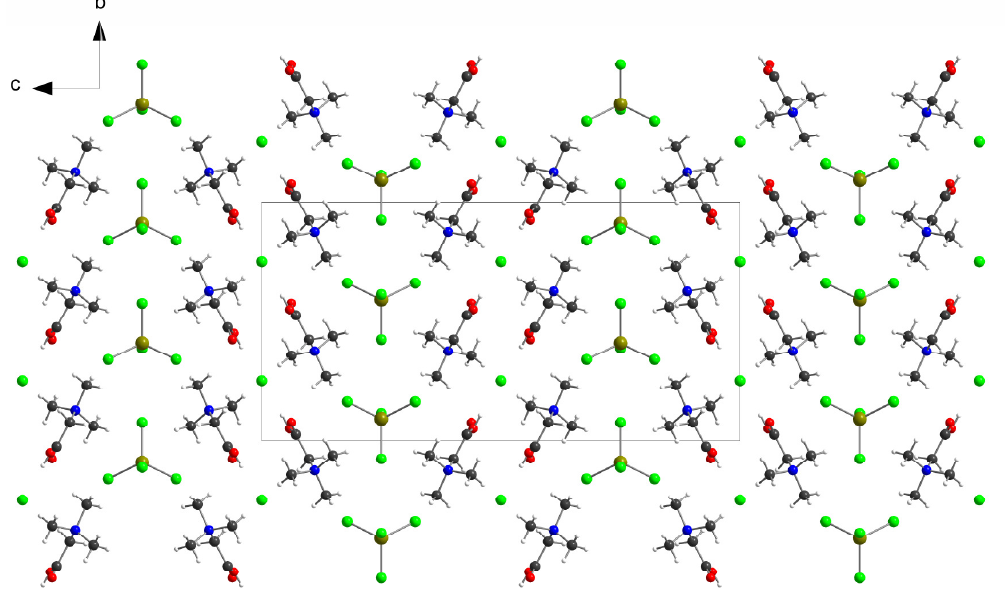
Cl[FeCl ] (view down the a 2 4